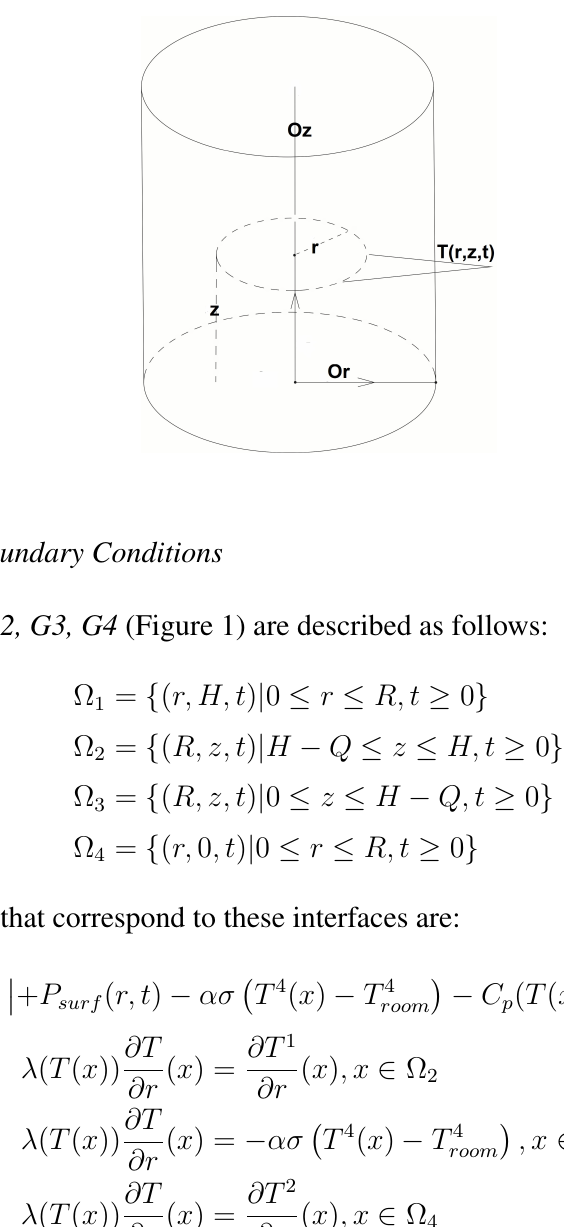
Figure 2. Cylindrical metal ingot, T ( r, z, t ) —the temperature at the moment t in the ingot’s point with coordinates ( r, z )